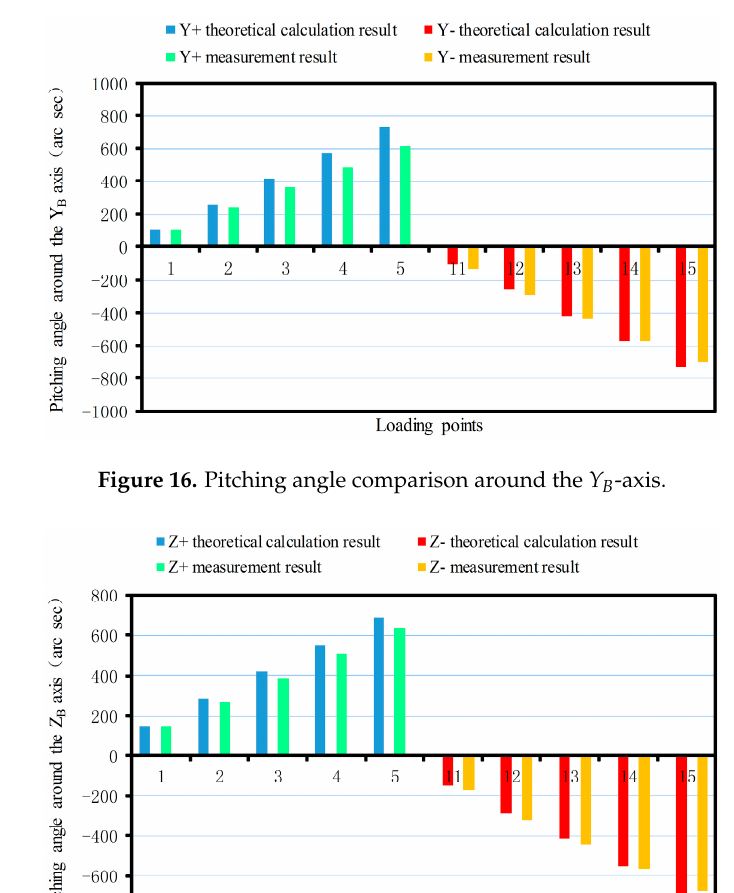
Z -axis. B Z -axis. B Z -axis. B